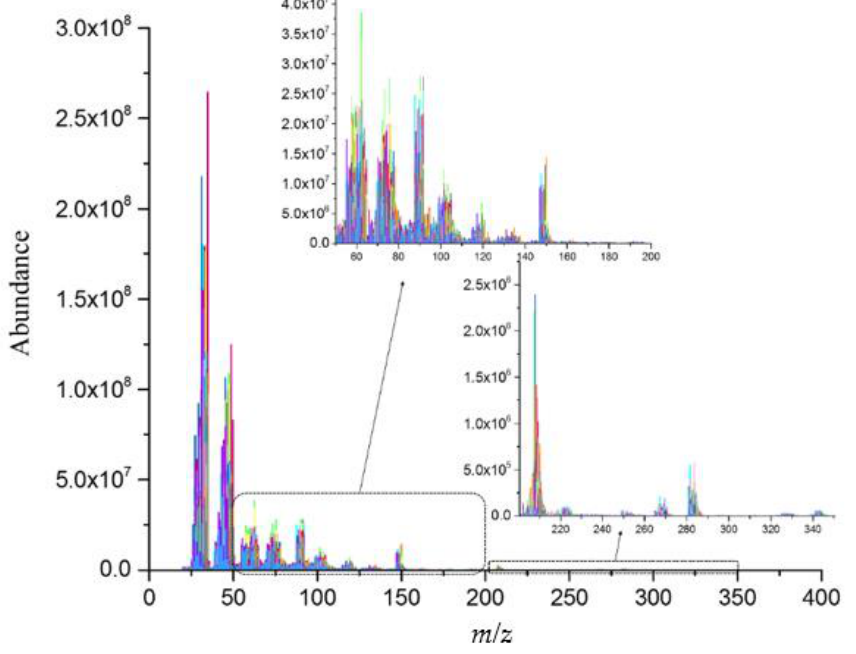
Figure 5. Total mass spectrum of 262 kinds of Chinese liquors obtained using the GC × GC/TOF-MS method.